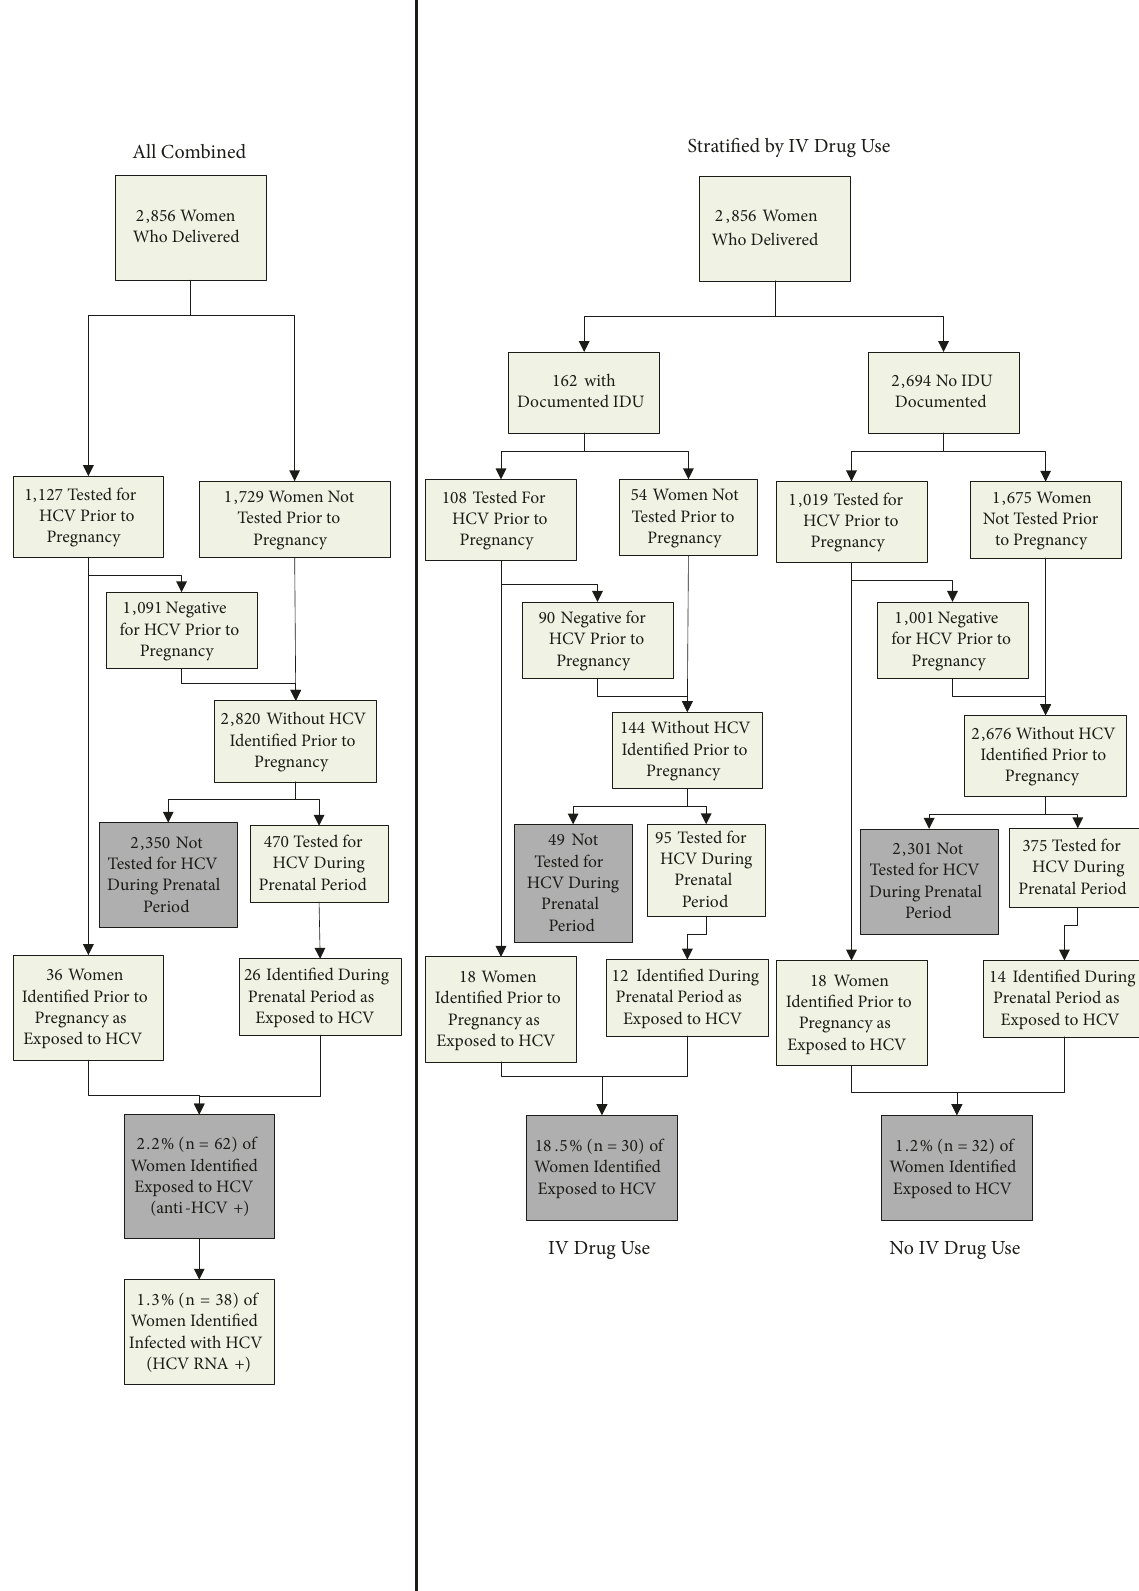
Figure 1: Flow diagram of those included in the evaluation to determine exposure to hepatitis C among women who delivered infants, 2013-2016. Gray boxes highlight the outcomes of